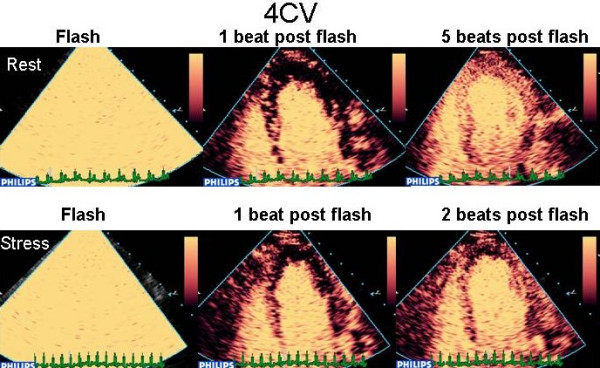
A clear apical defect is evident 2 beats post flash at peak stress (bottom line) which was not evident at rest (top line), consistent with LAD stenosis. [See additional files 26-39 for full case movies, additional file 40 for angiogram and additional file 49 for curve fits].